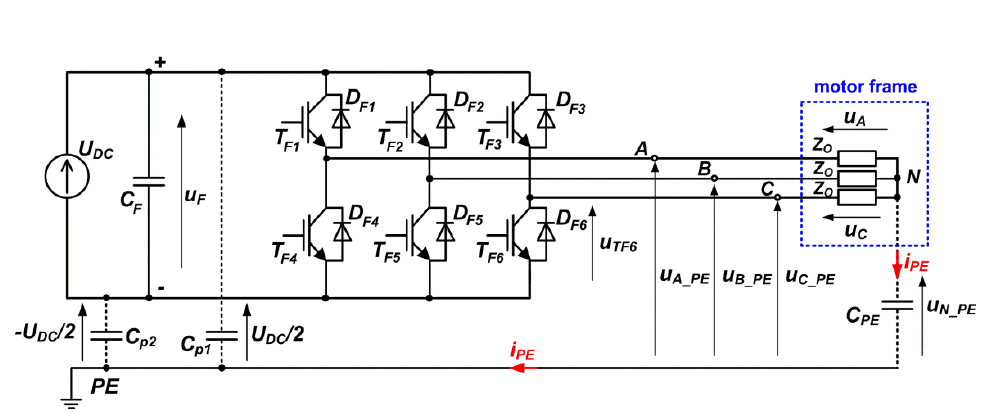
Figure 3. Electric drive fed by a conventional hard-switched two-level bridge voltage inverter. At steady state, voltage u C_PE equals U DC /2 if transistor T F6 is turned off, or u C_PE = − U DC /2 if transistor T F6 is turned on. Analogous relations may be formulated for output voltages u A_PE and u B_PE